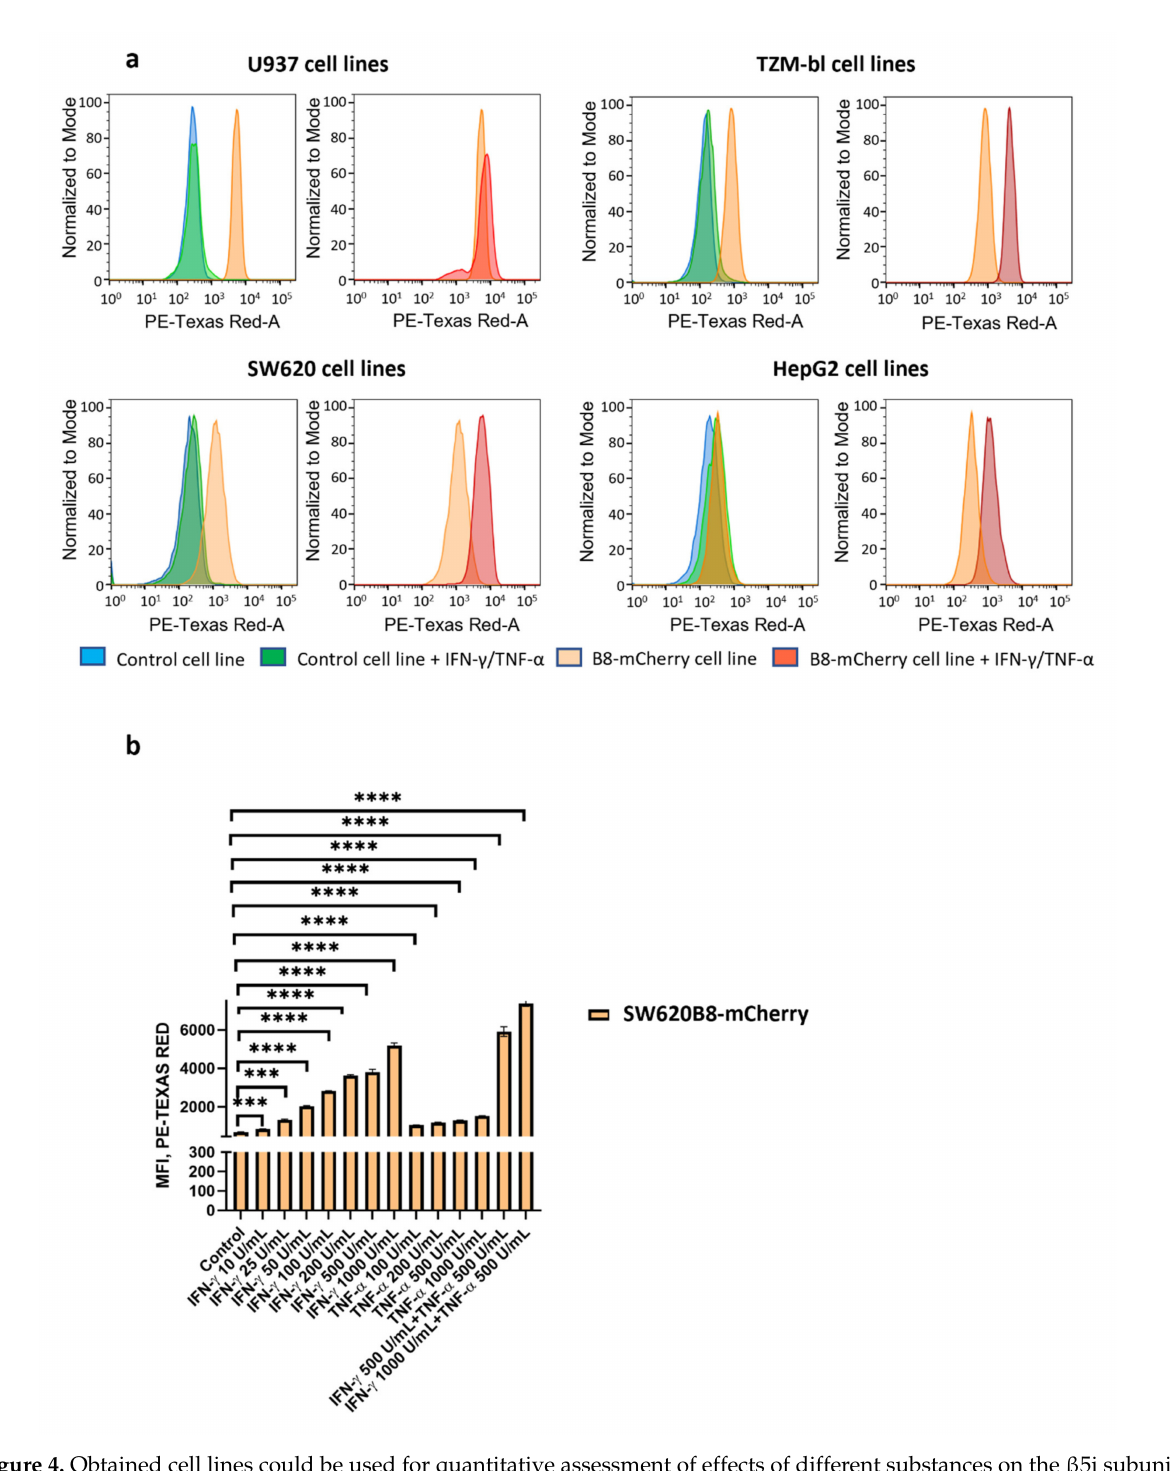
Figure 4. Obtained cell lines could be used for quantitative assessment of effects of different substances on the β 5i subunit expression. ( a ) Flow cytometry was used for the quantitative estimation of β 5i expression after stimulation of U937, SW620, TZM-bl, HepG2, U937B8-mCherry, SW620B8-mCherry, TZM-blB8-mCherry and HepG2B8-mCherry cells with 1000 U/mL of IFN- γ and 500 U/mL of TNF- α . For every pair of control and modified cell line representative histograms were obtained. Left panel—representative flow cytometry histogram showing mean cellular fluorescence of control cells (blue), cytokine- stimulated control cells (green) and unstimulated edited cells (orange). Right panel—representative flow cytometry histogram showing mean cellular fluorescence of unstimulated edited cells (orange) and edited cells treated with IFN- γ and TNF- α (red). ( b ) The fluorescence of SW620B8-mCherry cells treated with different concentrations of IFN- γ , TNF- α or two combinations of IFN- γ and TNF- α for 72 h. Tests were performed in triplicates. *** p < 0.001; **** p < 0.0001; t